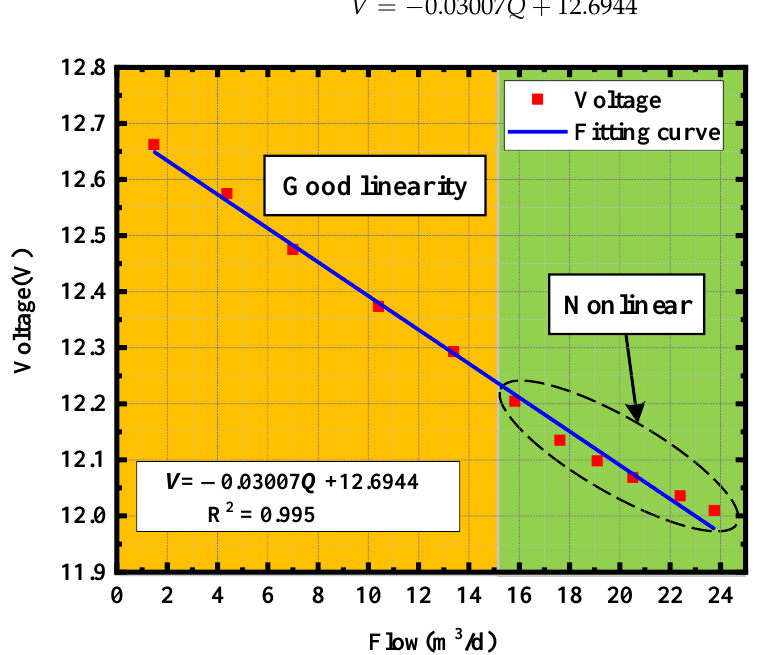
Figure 6. Linear diagram of voltage versus flow rate.